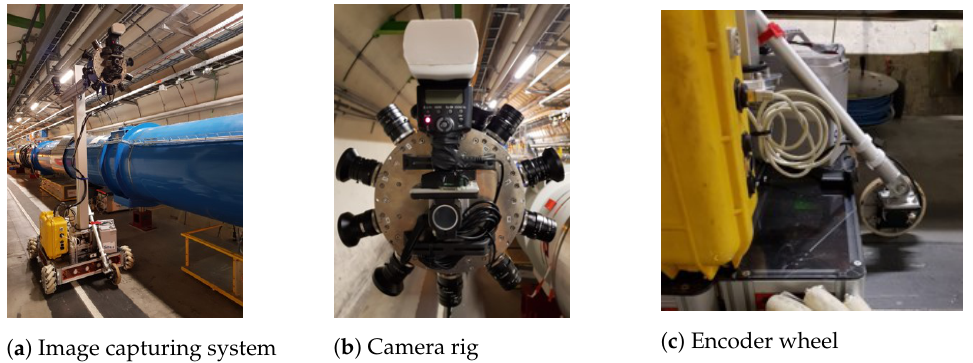
Figure 2. Commercial camera system integrated on the CERNBot. Image capturing system ( a ), camera rig ( b ), encoder wheel ( c